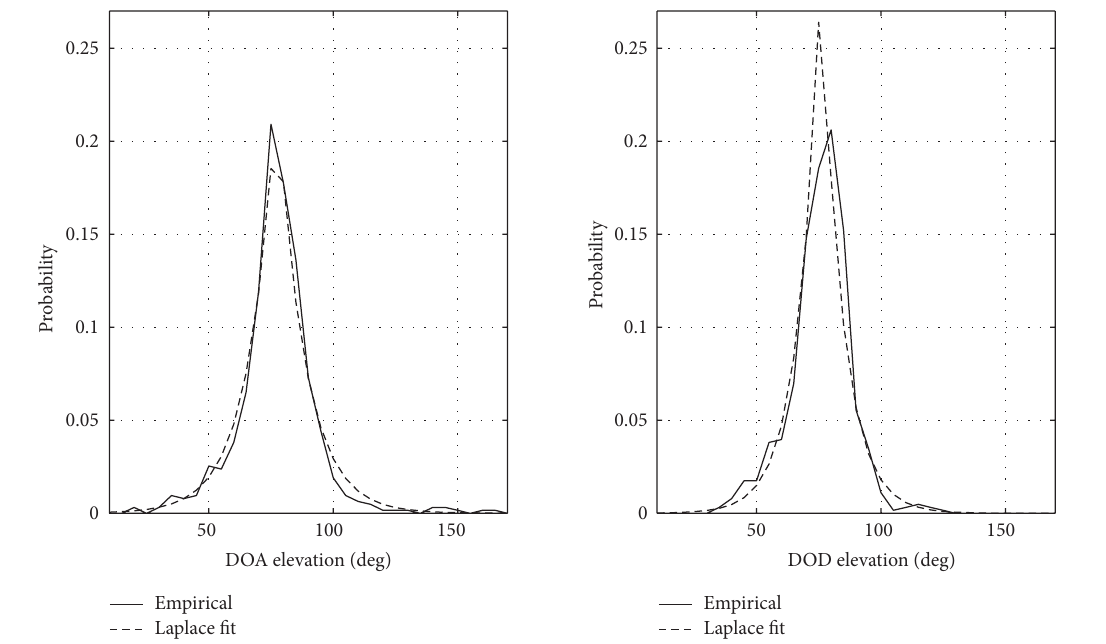
Figure 7: Pdf of DOA and DOD elevations.